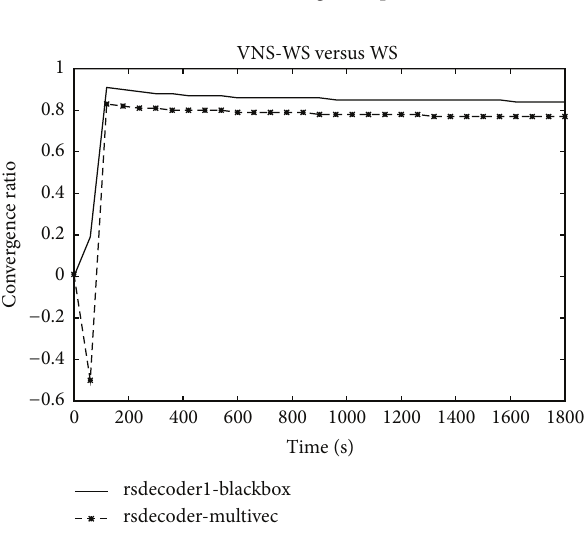
Figure 7: WS versus VNS-WS: clause to variable